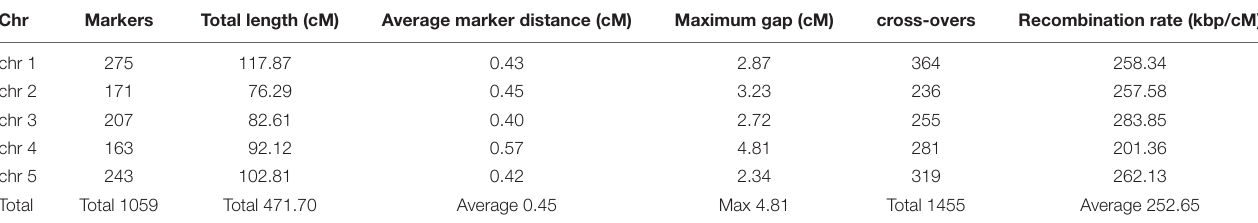
TABLE 1 | Characteristics of the 1059 marker genetic map using 160 RILs.